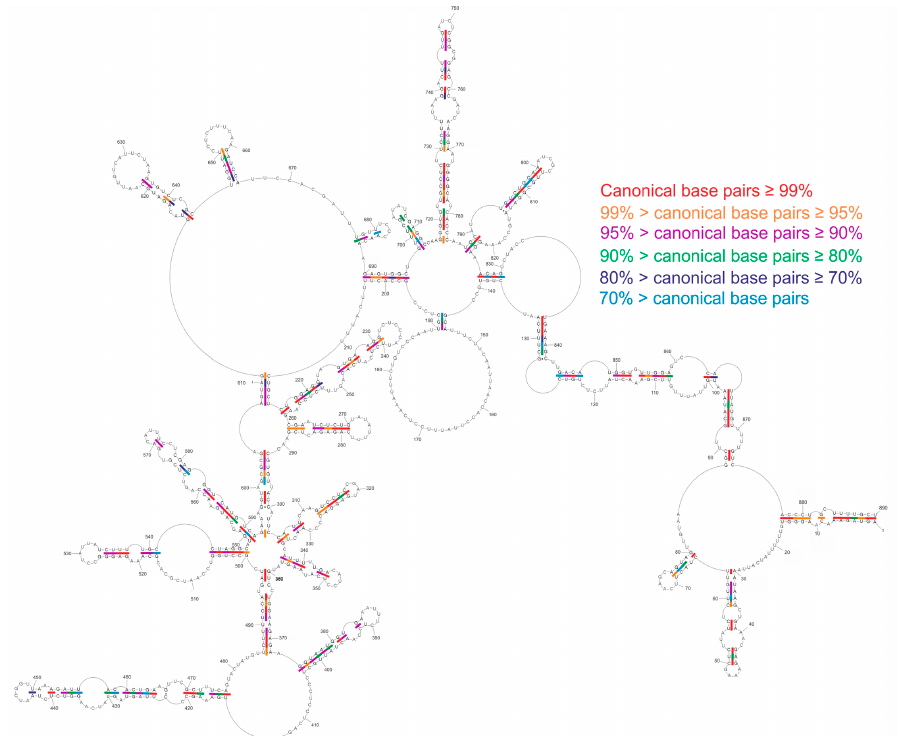
Figure 7. Conservation of vRNA8 global structure across type A influenza. Base pair conservations were marked based on an analysis of 34,248 IAV strains sequences obtained from the NCBI Influenza Virus Database.